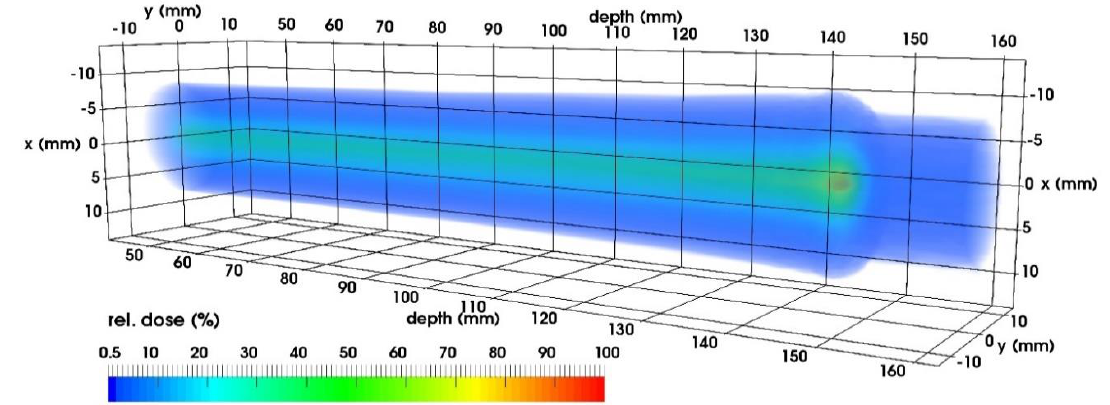
Figure 10. In this 3D representation of the dose, the carbon ion beam enters from the left. Lateral spread out, Bragg peak and fragmentation tail are visible.